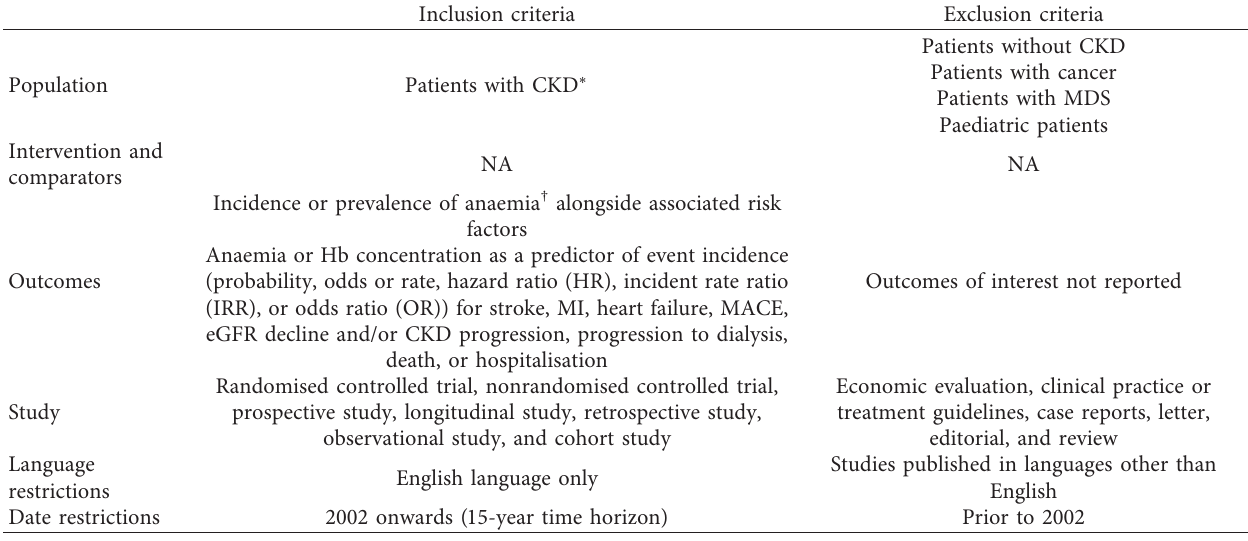
Table 1: PICOS eligibility criteria for the identification of